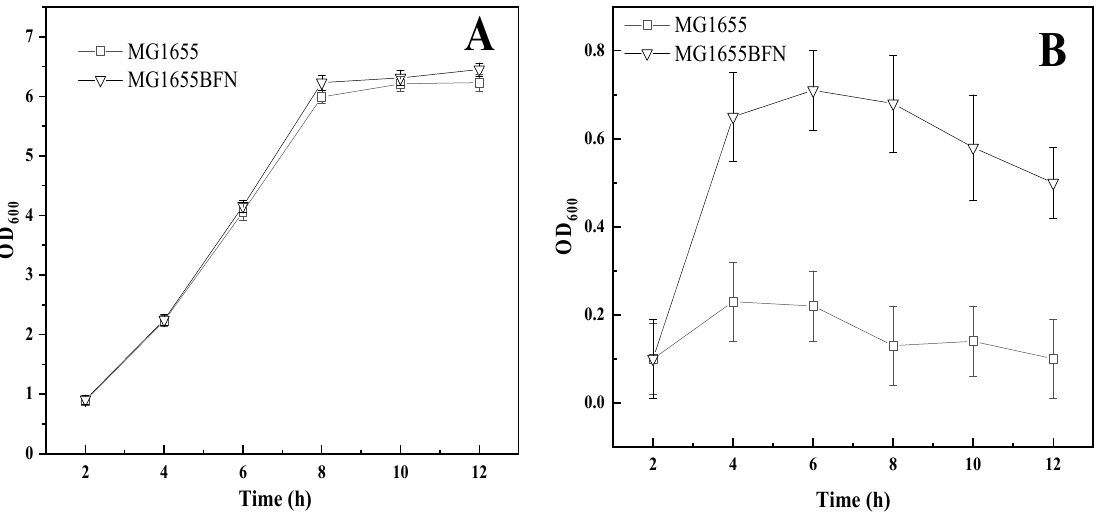
Figure 6. Growth of the E. coli MG1655BFN compared with E. coli MG1655 in the presence of 0% pinene ( A ) and 1% pinene ( B ). (- (cid:3) -) E. coli MG1655; (- ∇ -) E. coli MG1655BFN.